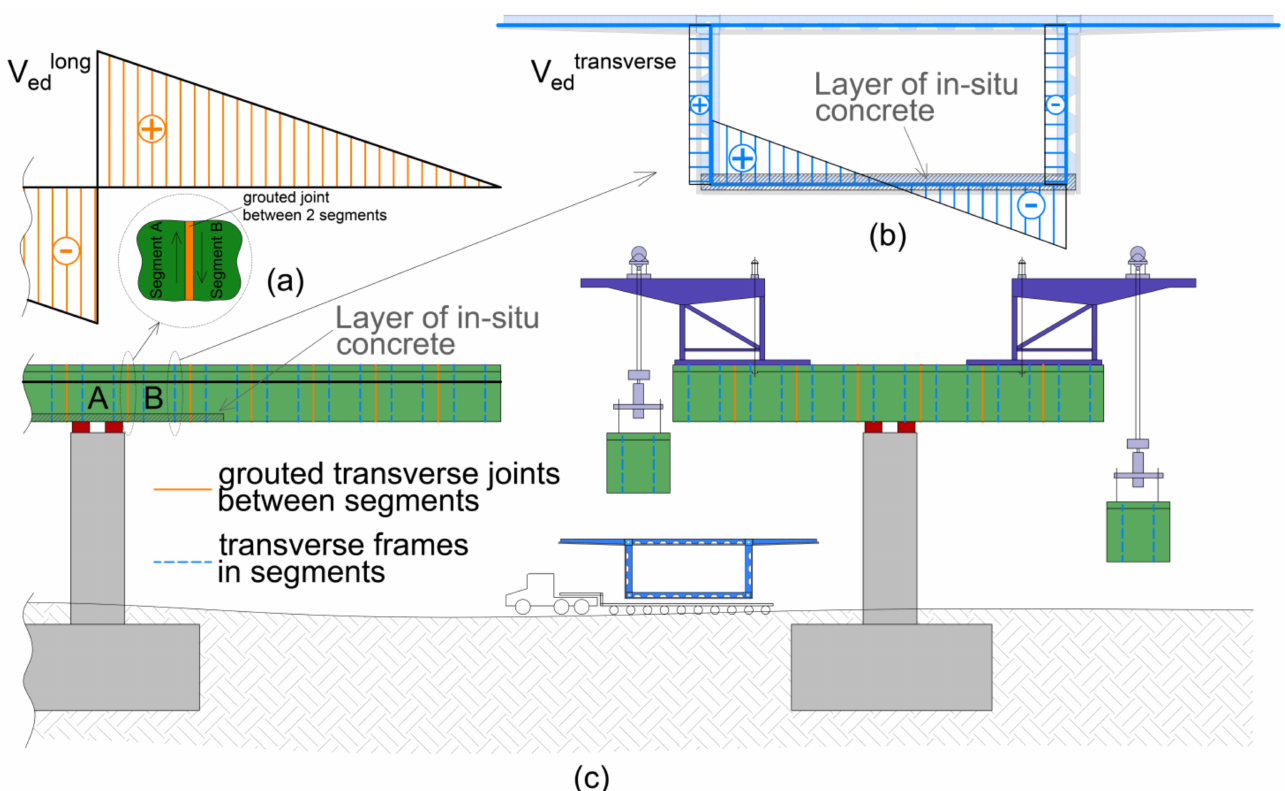
Figure 2. Application of thin-walled pre-fabricated elements for the construction of a balanced cantilever bridge with lifting frames: ( a ) distribution of shear forces in longitudinal direction due to self-weight; ( b ) distribution of shear forces in a cross-frame due to adding in-situ concrete to the bottom slab ( c ) illustration of the construction process (drawing based on